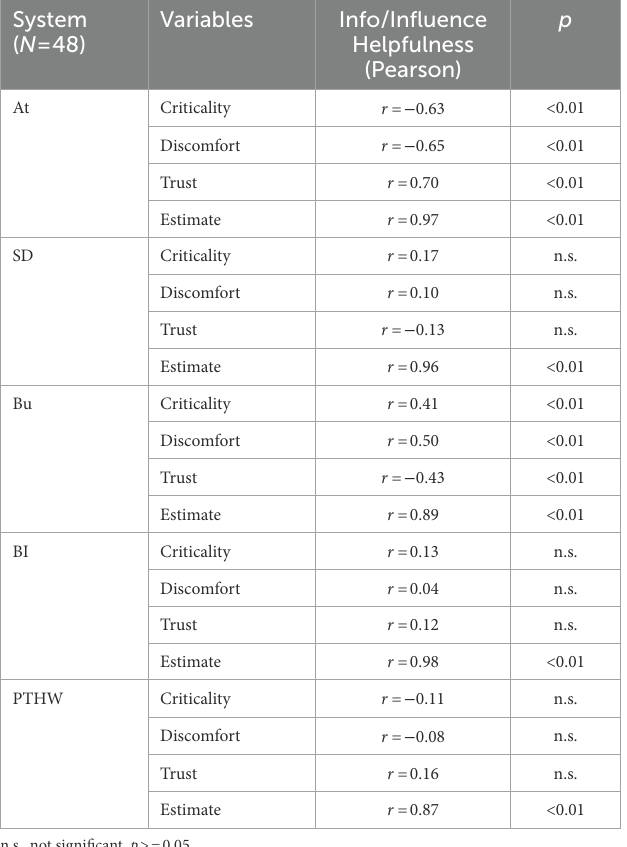
TABLE 1 Pearson correlations between the helpfulness of the displayed information/provided influence and the variables criticality, discomfort, trust in the driver and the helpfulness of the assistance system to better estimate the scenario by assistance system. System ( N =